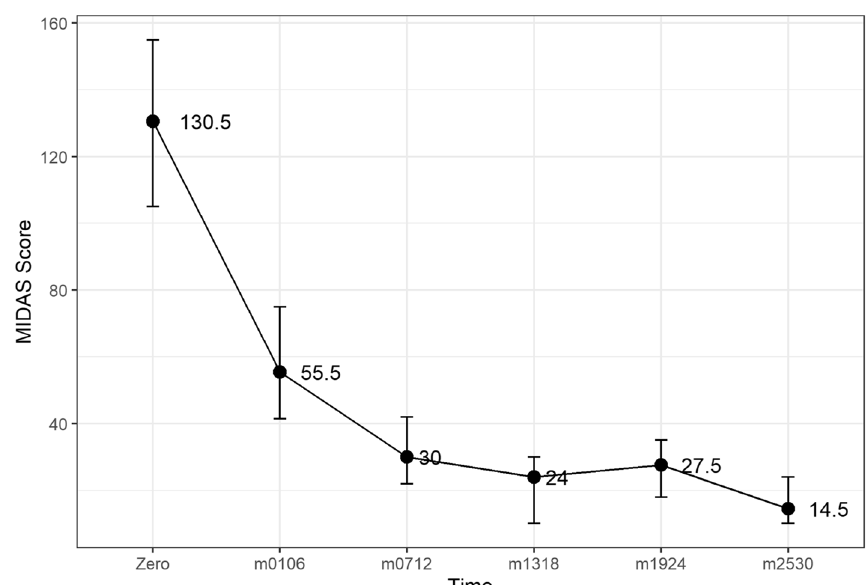
Fig. 2 Median MIDAS score at baseline (y-axis) and up to 30 months of follow-up (x-axis). Ninety-five percent confidence interval of median shown by vertical bars